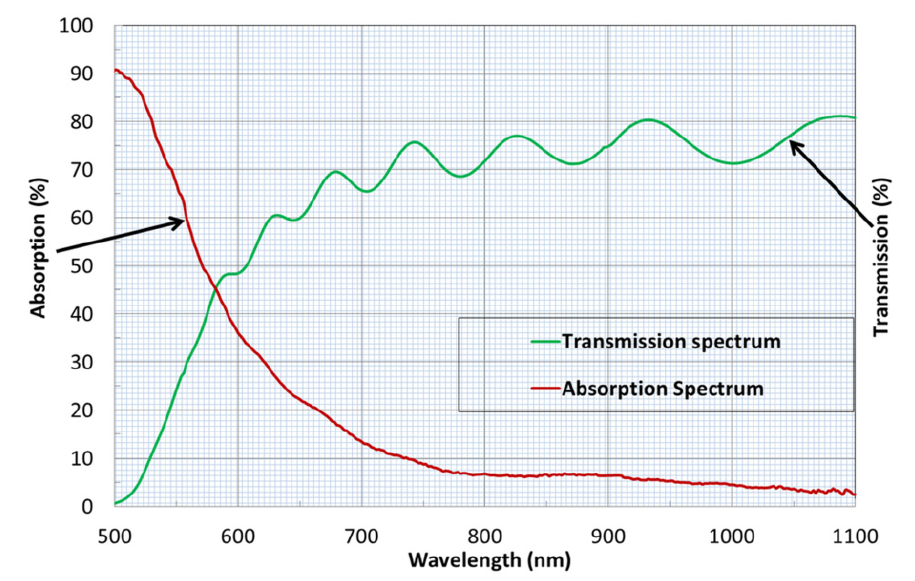
Figure 6. Measured transmission (green line) and absorption (red line) spectra of a multilayer garnet structure (SD3) described by (Sub (GGG)/(500 nm Bi 2 Dy 1 Fe 4 Ga 1 O 12 )/ (500 nm Bi 3 Fe 5 O 12 : 6 vol. % Dy 2 O 3 )/(500 nm Bi 2 Dy 1 Fe 4 Ga 1 O 12 )) deposited onto GGG (111) substrate (and annealed for 3 h at 650 °C after the